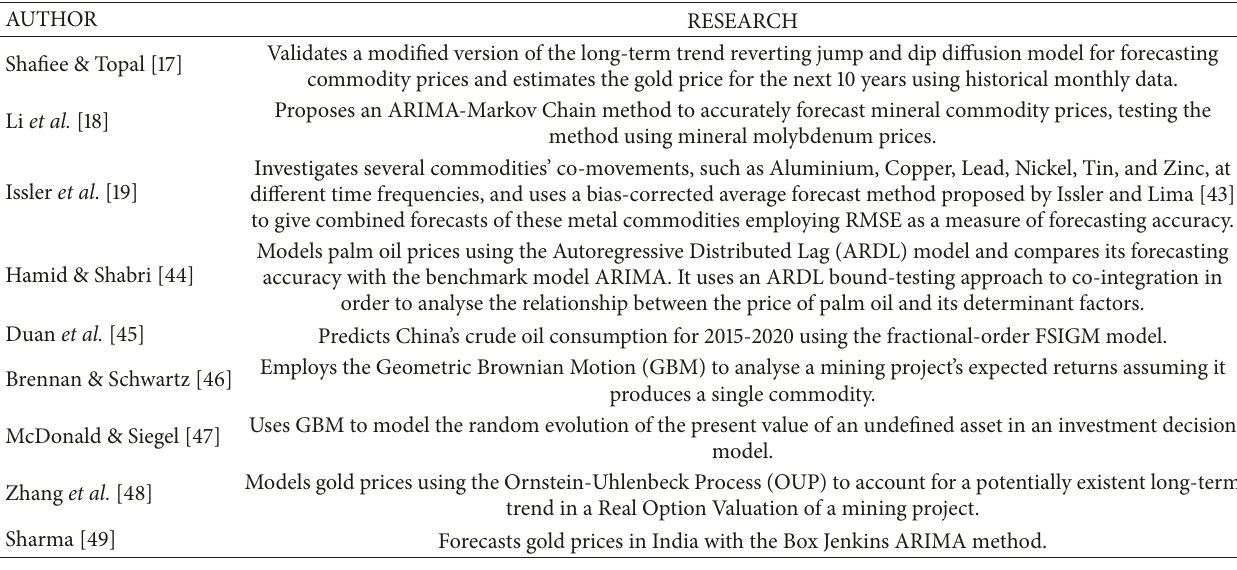
Table 1: Summary of previous literature